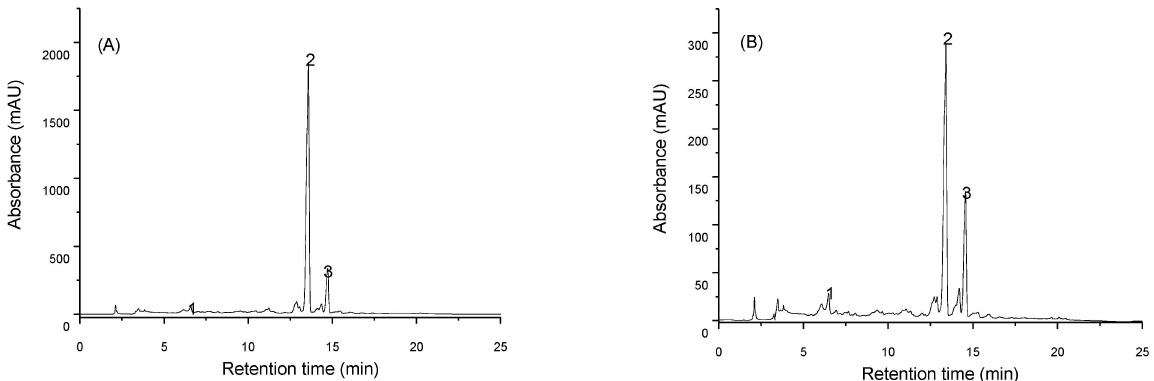
Figure 1. Identification of individual carotenoids recovered from tomato peels of cold break ( A ) and hot break ( B ) processing lines. 1—lutein, 2—lycopene, 3— β -carotene.